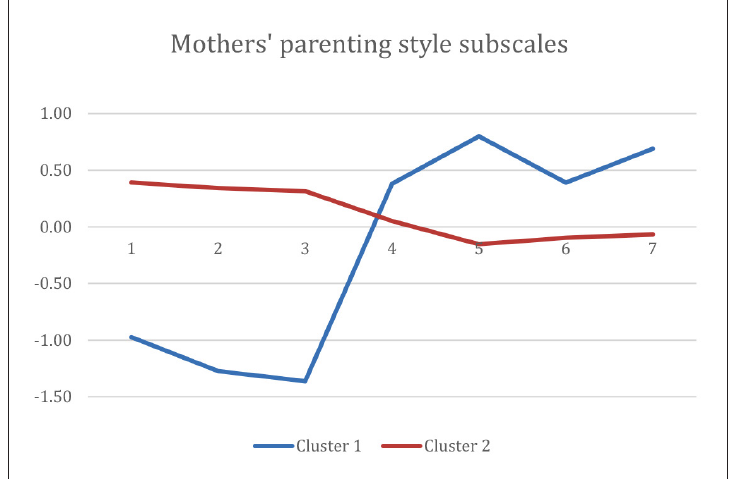
Figure. Mothers’ PS subscales’ cluster